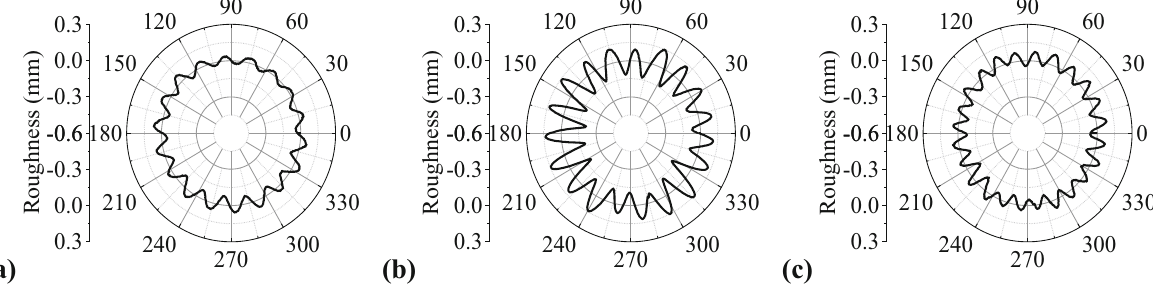
Fig. 4 Typical measurement results of polygonal wear of locomotive wheels with a 18 harmonics, b 19 harmonics, and c 24 harmonics described in polar coordinates [18]. The nominal wheel diameter is 1250